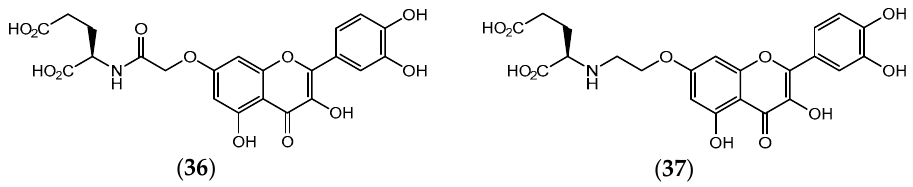
Figure 12. Chemical structure of quercetin- glutamic acid derivatives with non-hydrolysable link- age.